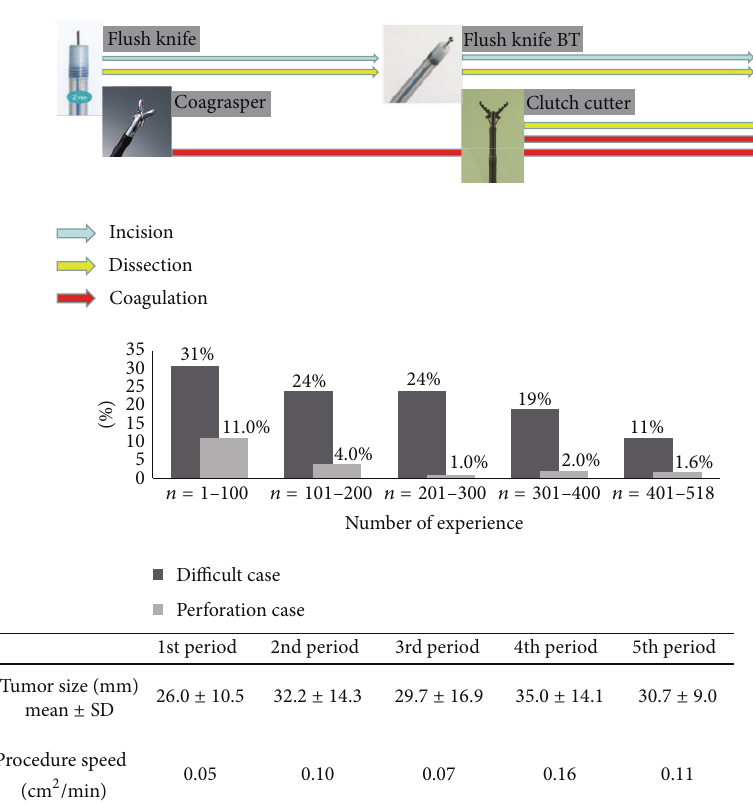
significantly lower than those in the 1st period (11.0% versus 1.0%, 𝑃 < 0.05 ; 11.0% versus 2.0%, 𝑃 < 0.05 ; 11.0% versus 1.6%, 𝑃 < 0.05